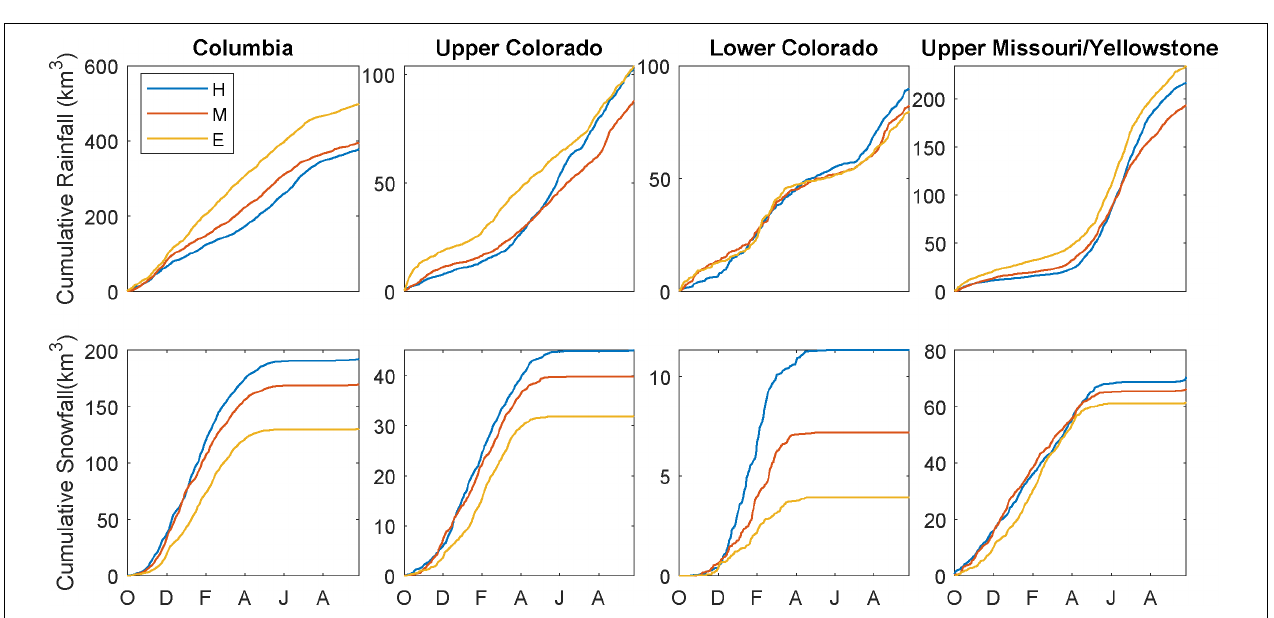
FIGURE 5 | Comparison of average annual cumulative rainfall (top row) and snowfall (bottom row) for the four western watersheds for the historic (blue), mid-century (orange), and end-century (yellow) decades.